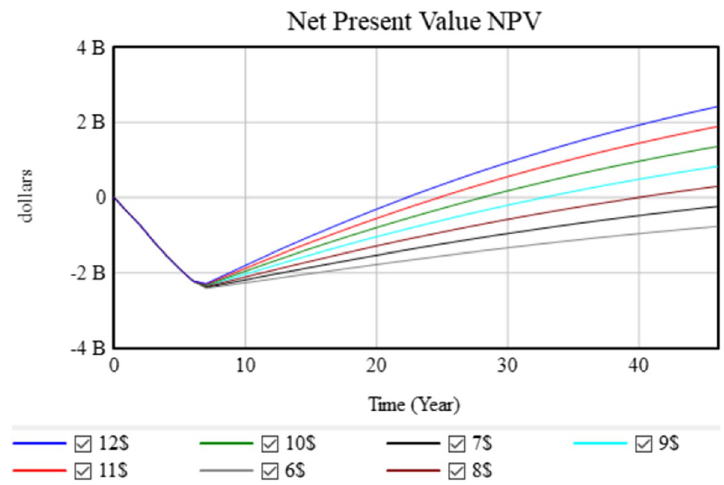
Fig. 12 The NPV dynamic behavior for the concession price change